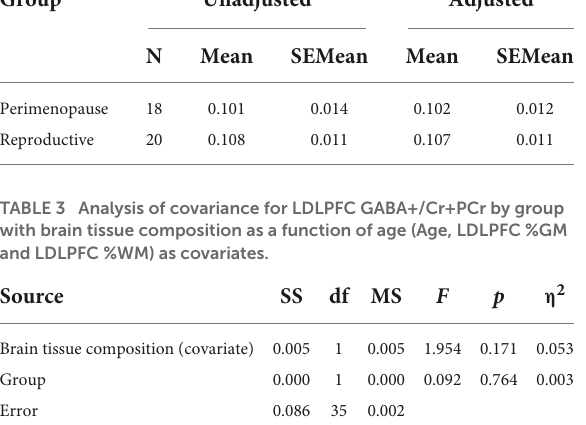
TABLE 2 Unadjusted and covariate adjusted descriptive statistics for LDLPFC GABA+/Cr+PCr. Group